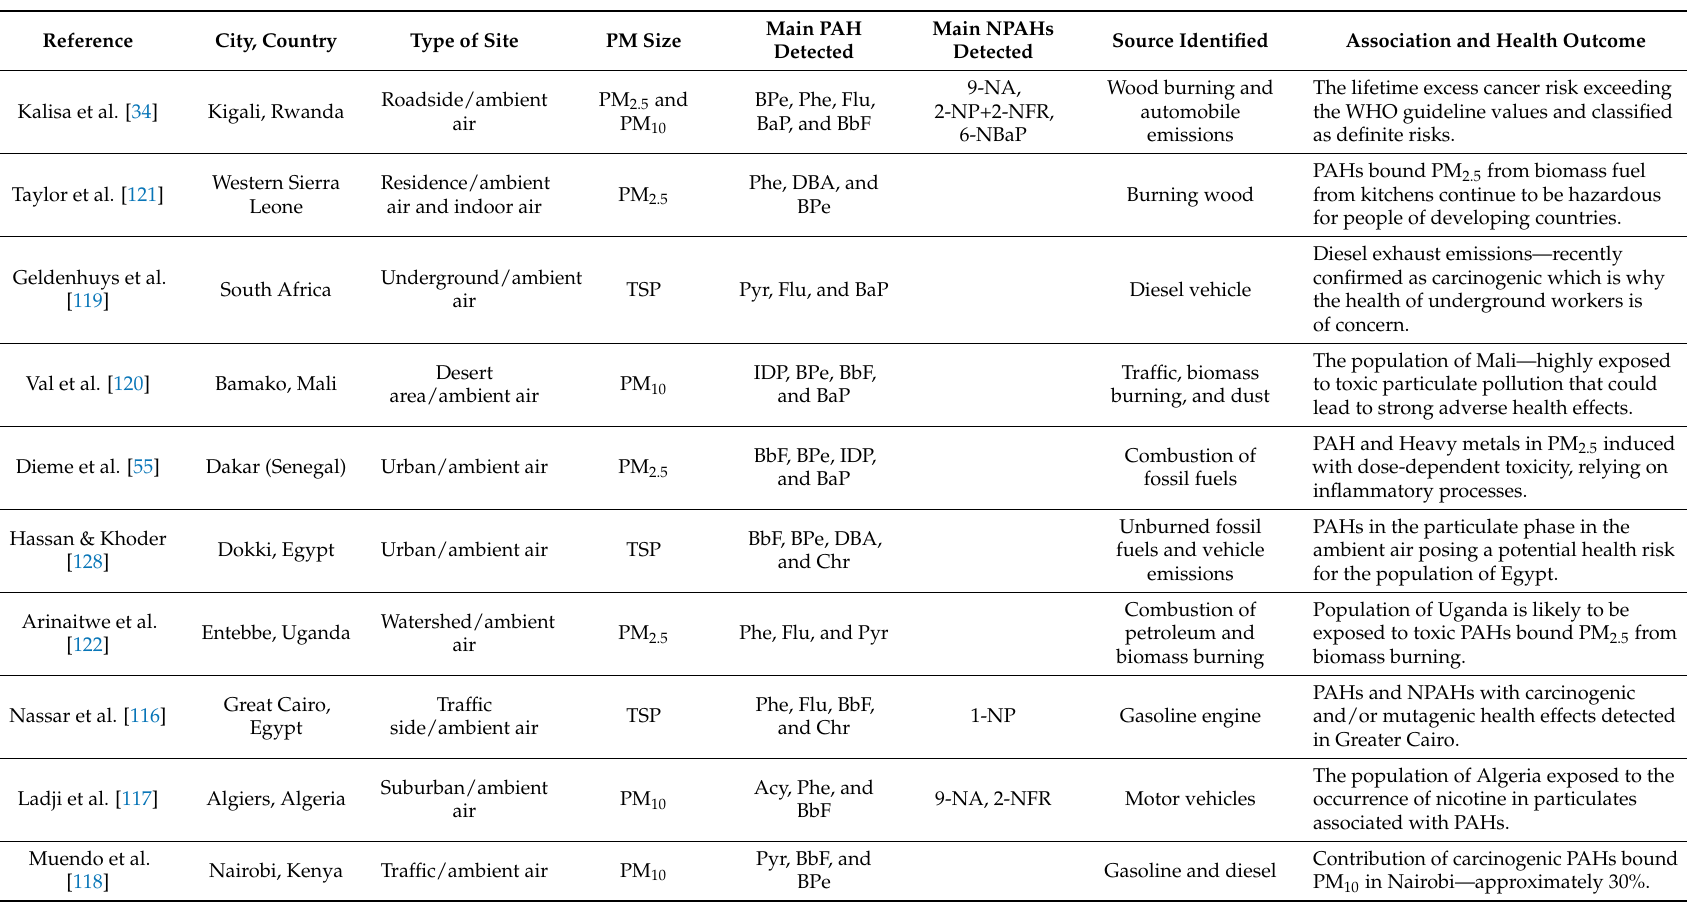
Table 2. Summary of epidemiological and toxicological studies conducted in Africa on health effects of exposure to mass concentration of ambient particulate matter size